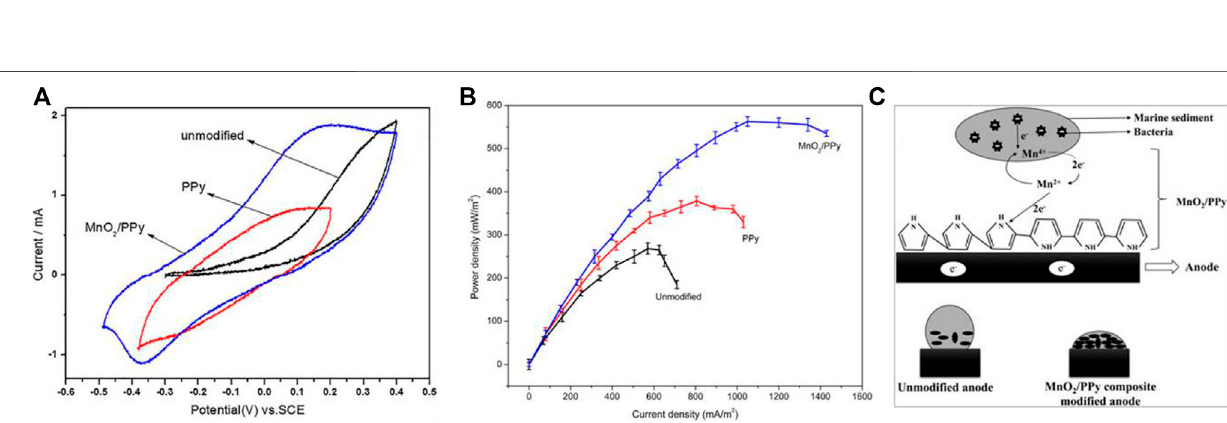
Frontiers in Nanotechnology |